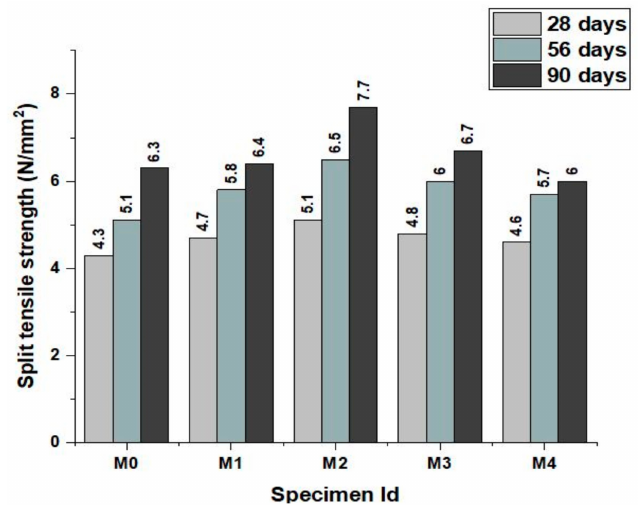
Figure 9. Split tensile strength of the concrete mixes at various ages.